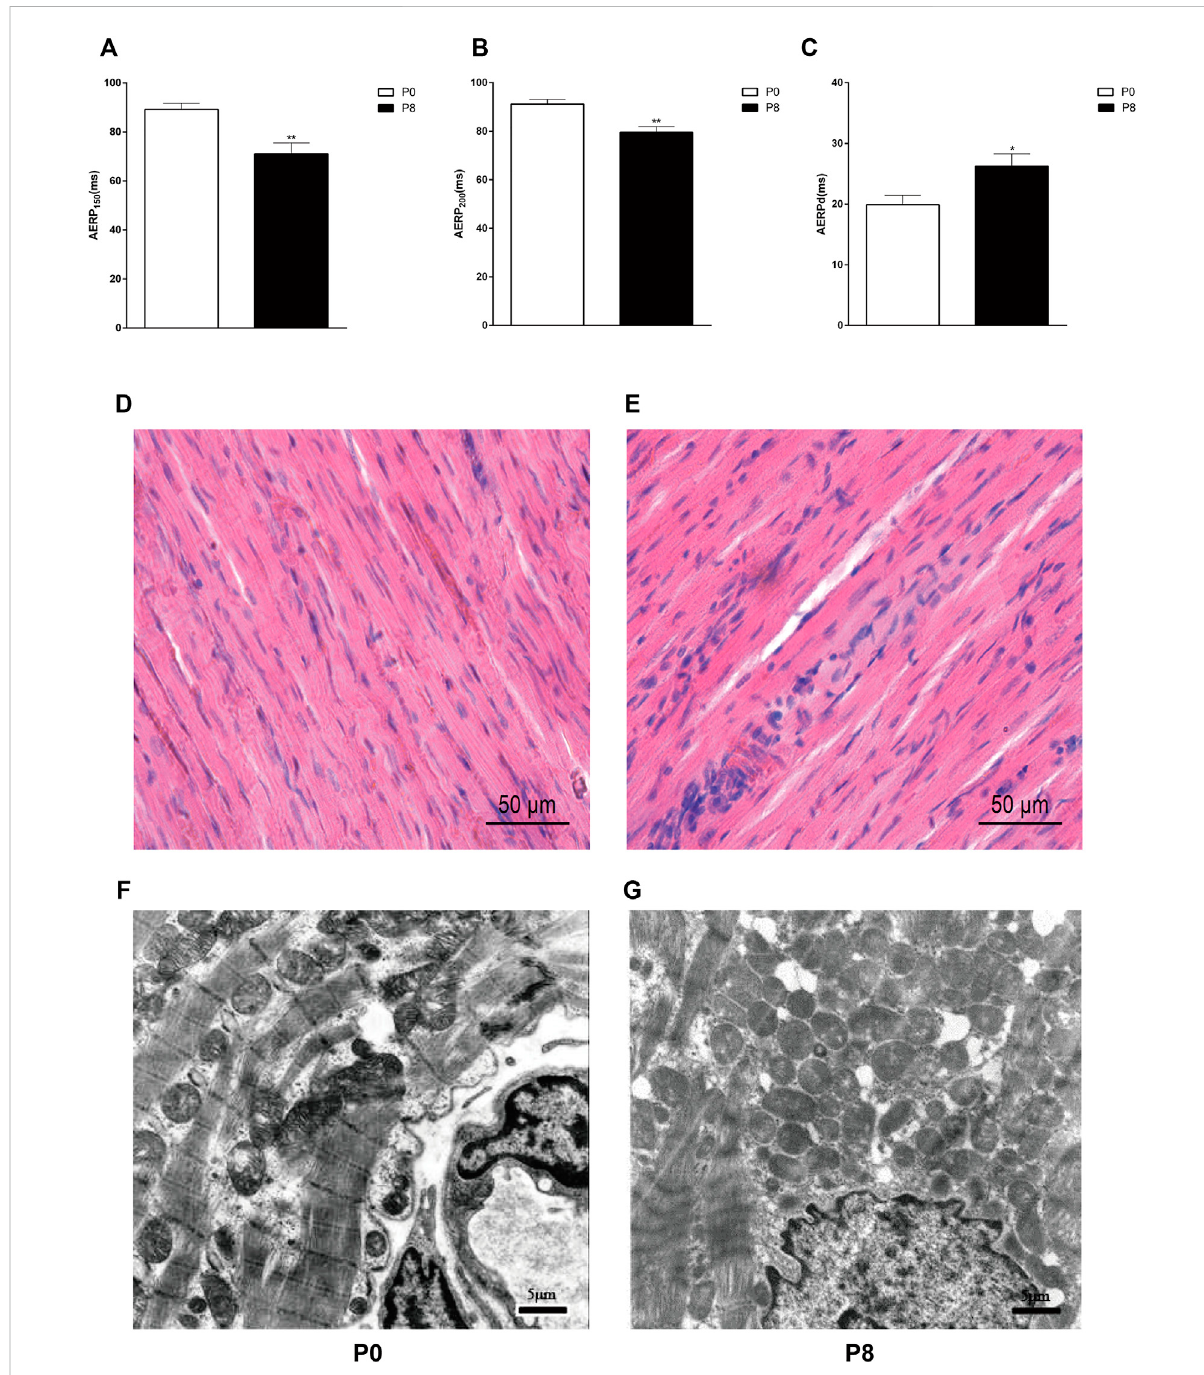
FIGURE 3 Rapidpacingrabbitatrialmodelwassuccessfullyestablished.ChangesinAERP 150 (A) ,AERP 200 (B) ,andAERPd (C) afterrapidpacingstimulation. ** p < 0.01 vs. P0; * p < 0.05 vs. P0. Effects of rapid pacing on the morphological structure and atrial ultrastructure of atrial muscles in rabbits. (D) Cell structure was complete, and the myocardial fi ber was evenly distributed and arranged vertically and horizontally. The atrial tissue is from the right atrialofP0. (E) Cellboundarydistributionwasunclear.Thearrangementsofmyocardial fi berweredisordered,andthenormalnetworkstructure waslost andleukocytein fi ltration wasalso observed.The atrialtissue isfrom theright atrialofP8. (F) Ultrastructure ofcardiomyocytes inP0